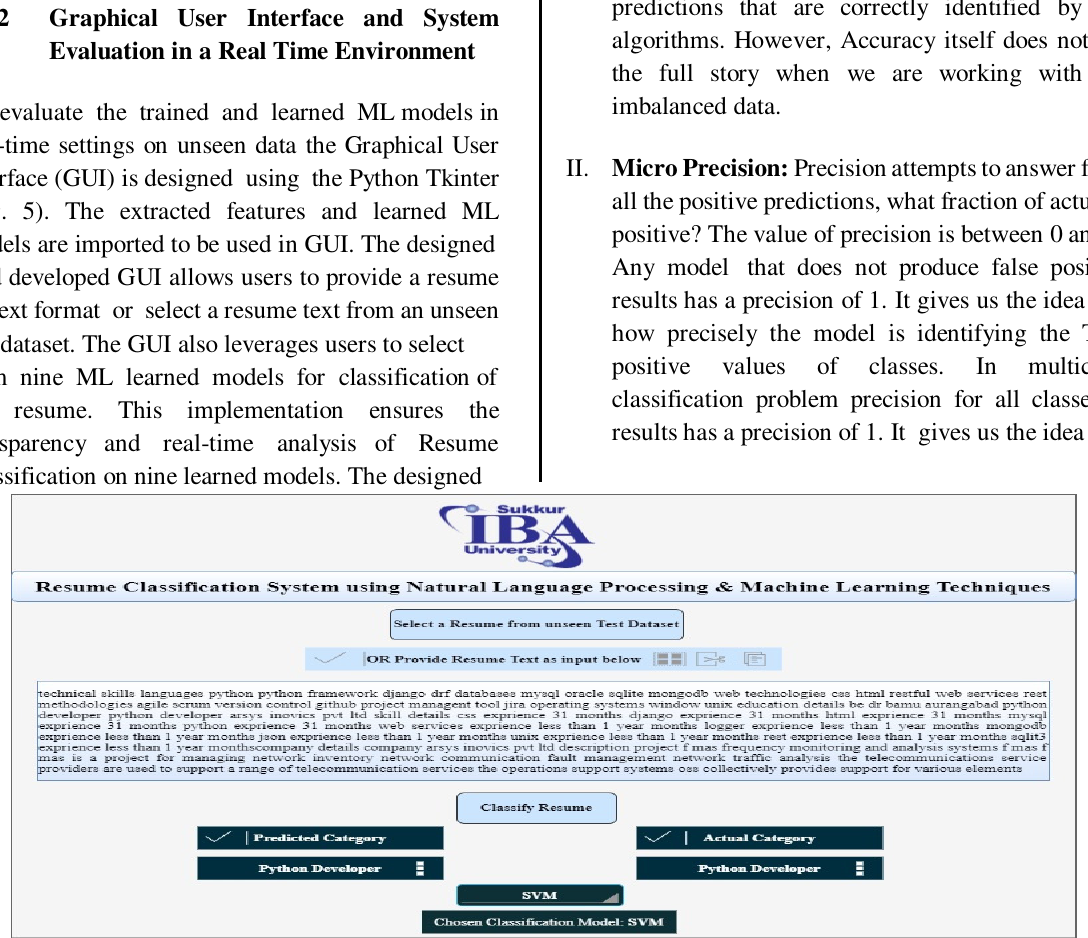
Fig. 5: Graphical User Interface of the proposed